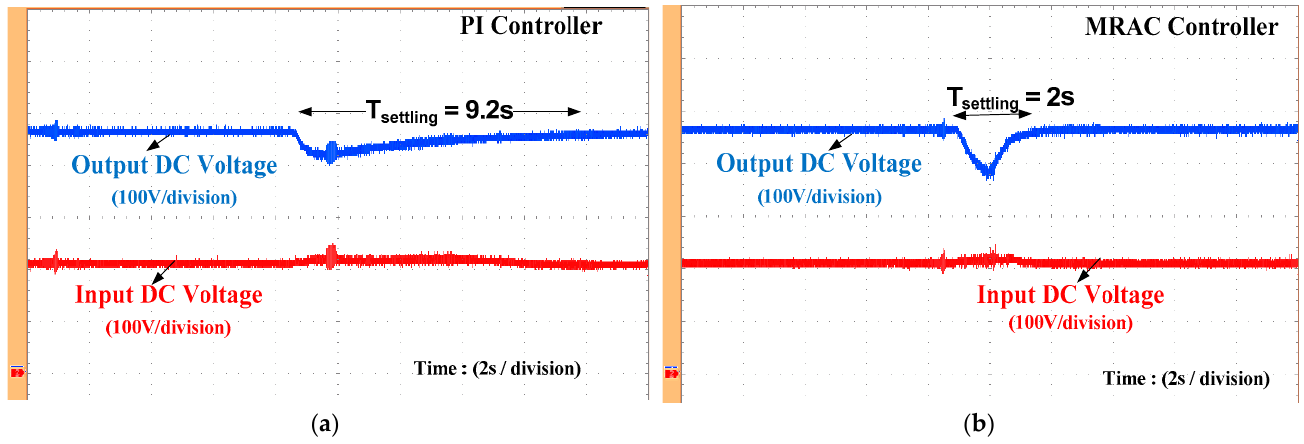
Figure 12. ( a ) Input and output voltage of the boost converter for a rise in power demand with PI controller; ( b ) input and output voltage of the boost converter for a rise in power demand with MRAC controller.